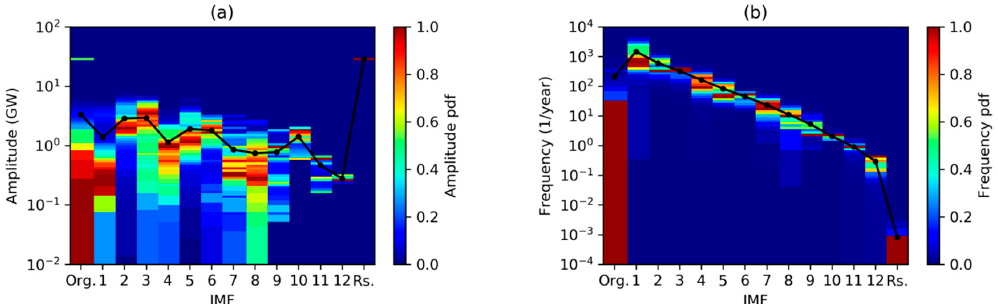
value is plotted as a black line.